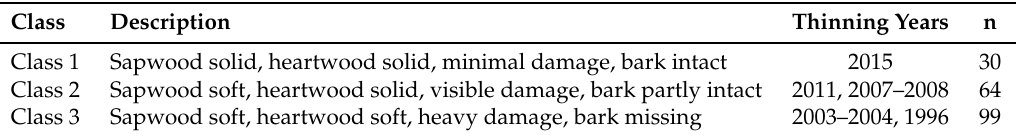
Table 1. Stump decay classes with description, assumed thinnings, and number (n) of stumps per class. Class Description Thinning